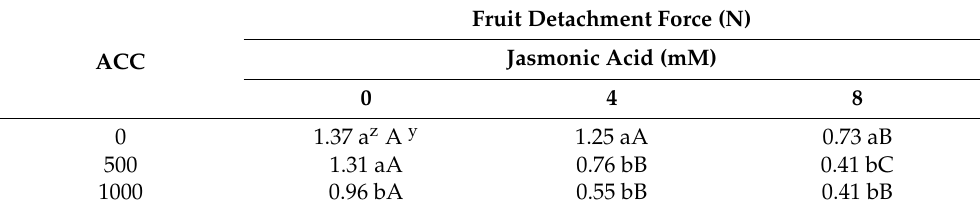
Table 3. The fruit detachment force of grapes treated with different combinations of ACC and JA. Measurements were made 3 DAT.